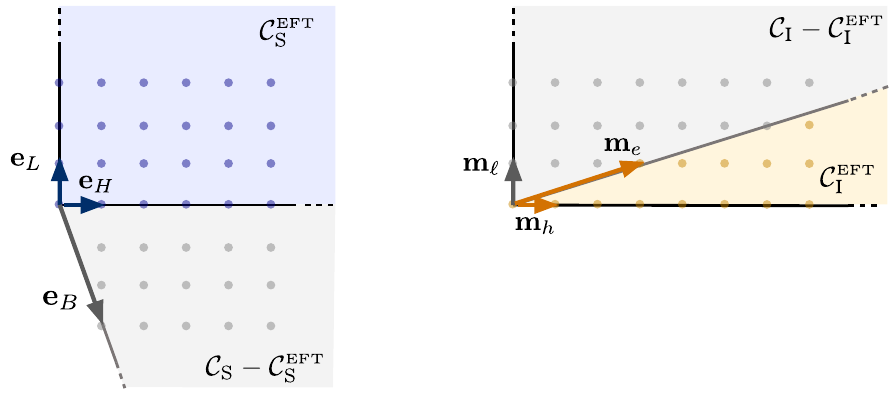
⊂ C S and C EFT ⊂ C I of the S I